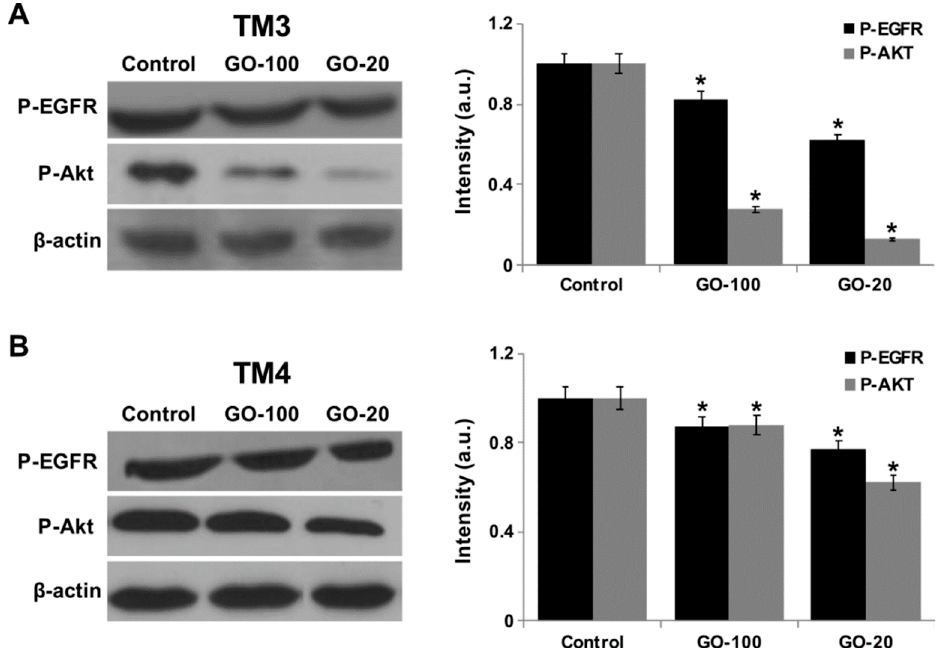
Figure 9. GO-100 and GO-20 graphene sheets alter phosphorylation levels of EGFR/AKT. ( A ) TM3 cells were treated with GO-100 and GO-20 at a dose of 50 µ g/mL for 30 min. Total proteins were extracted, and the phosphorylation levels of EGFR/AKT signaling pathway molecules were analyzed via western blot. ( B ) TM4 cells were treated with GO-100 and GO-20 at a dose of 50 µ g/mL for 30 min. Total proteins were extracted, and the phosphorylation levels of EGFR/AKT signaling pathway molecules were analyzed via western blot. The results are presented as the mean ± SEM from three independent experiments. The treated groups showed statistically significant differences from the control group by Student’s t -test (* p <